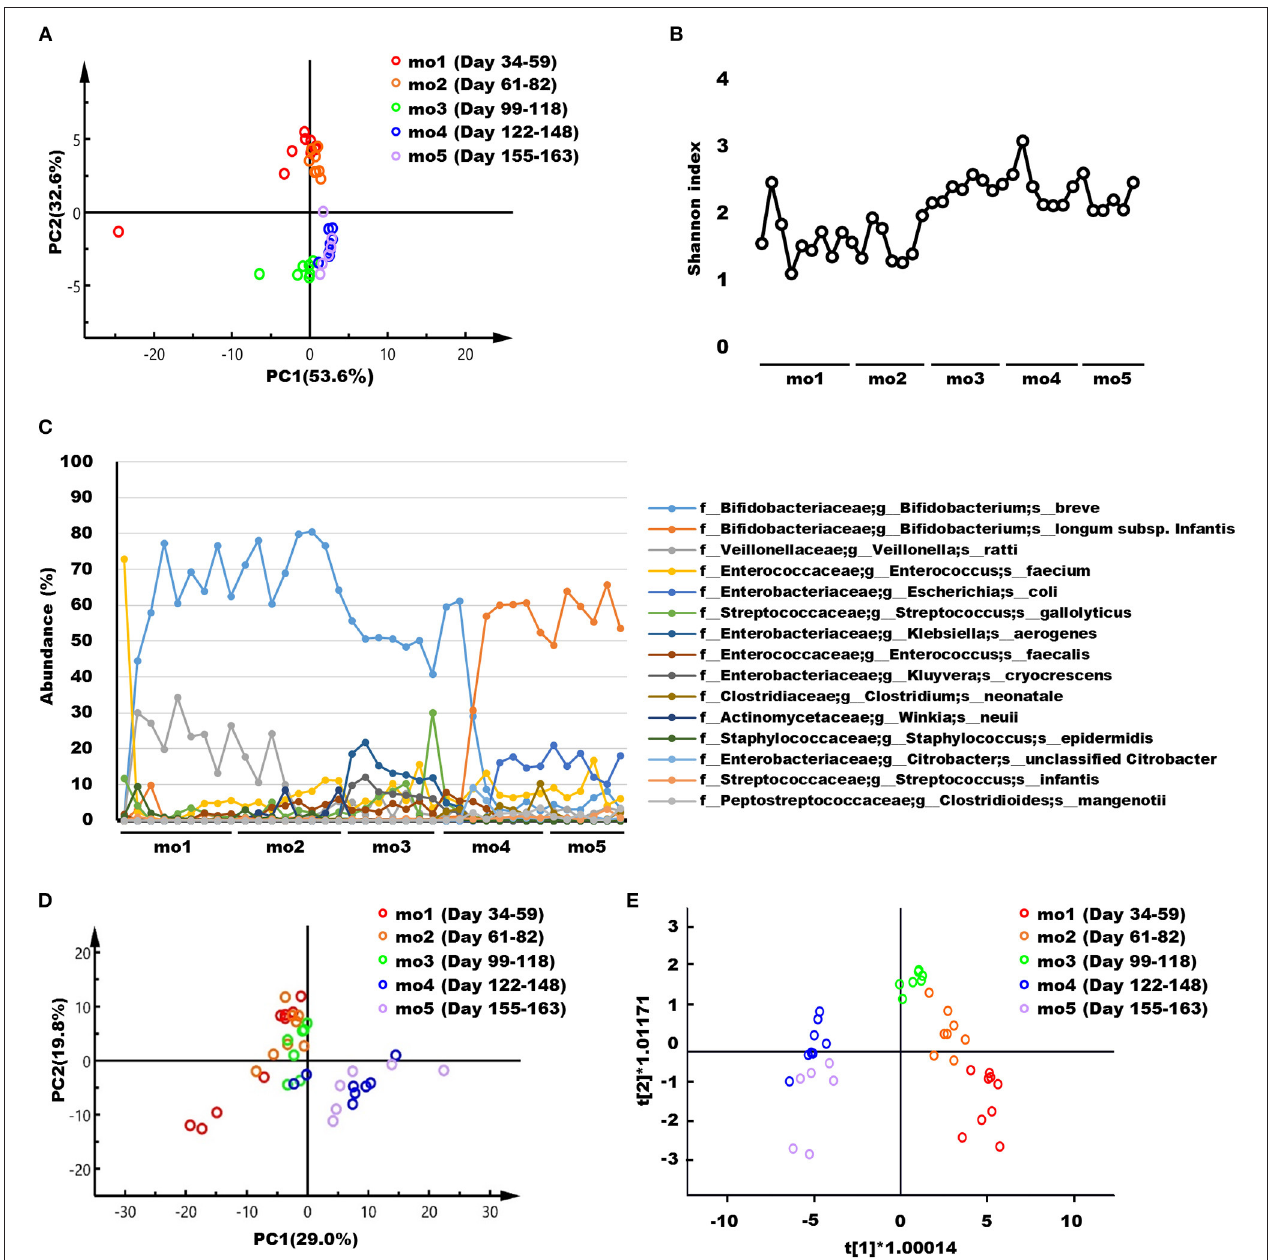
FIGURE 1 | (A) Principal component analysis (PCA) score plots based on the weighted UniFrac distance metric of the microbiome in infant feces samples collected at months 1–5 postpartum. Each symbol represents one individual feces sample. (B) Changes in the microbiome α -diversity, as assessed from the Shannon index, in infant feces samples collected at months 1–5 postpartum. (C) Transitions of 15 bacterial species with an average abundance of 0.5% or more during the lactation period. (D) PCA and (E) Orthogonal partial least squares discriminant analysis consisting of five groups score plots derived from the NMR spectra of infant feces samples collected at months 1–5 postpartum. R2X[1] = 0.568; R2X[2] = 0.048. Each symbol represents one individual feces sample. mo,